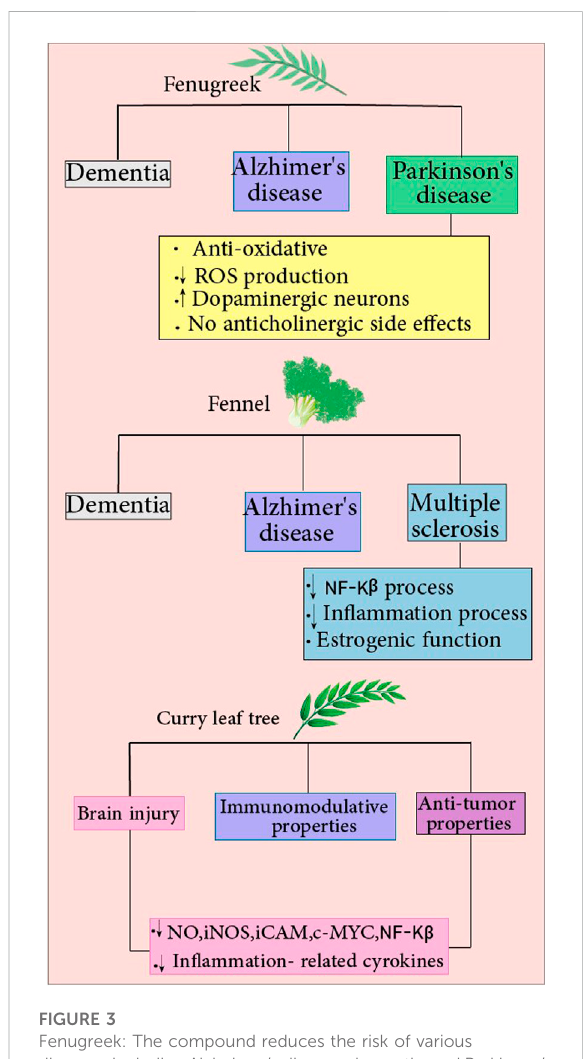
FIGURE 3 Fenugreek: The compound reduces the risk of various diseases, including Alzheimer ’ s disease, dementia, and Parkinson ’ s disease. Fenugreek protects against Parkinson ’ s disease by reducing ROS production, increasing dopaminergic function in neurons, and providing antioxidant properties with no anticholinergic side effects. Fennel: It reduces the risk of many diseases, including Alzheimer ’ s, dementia, and multiple sclerosis(MS). Fennel confers protection against MS by decreasing NF-K β and in fl ammation processes and having estrogenic activity. Curry leaf: Different features of this compound include antitumor